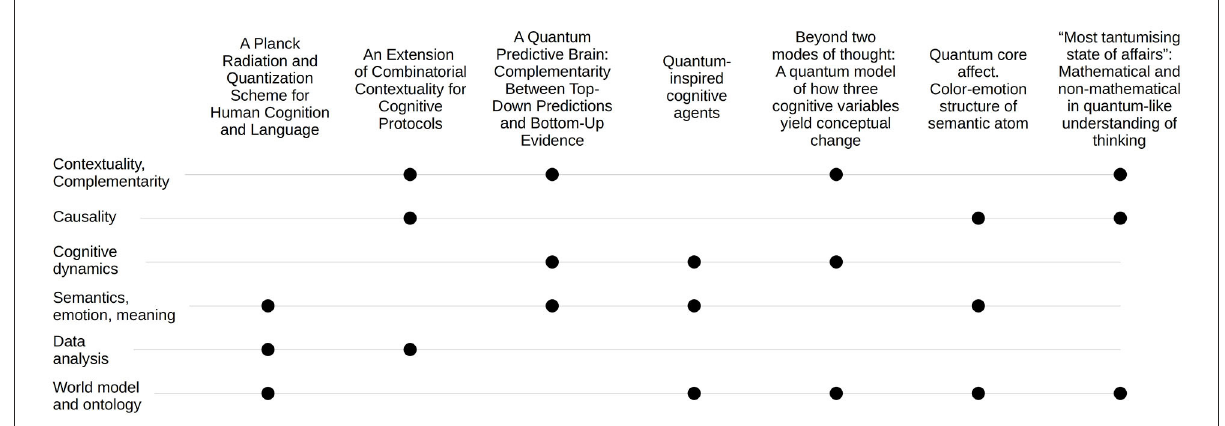
FIGURE1 Distribution of the papers among major